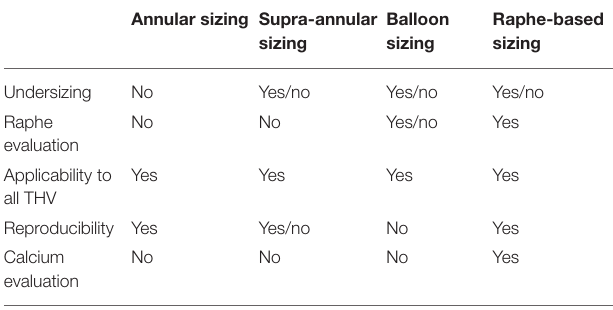
TABLE 1 | Principal characteristics of the currently available sizing methods for